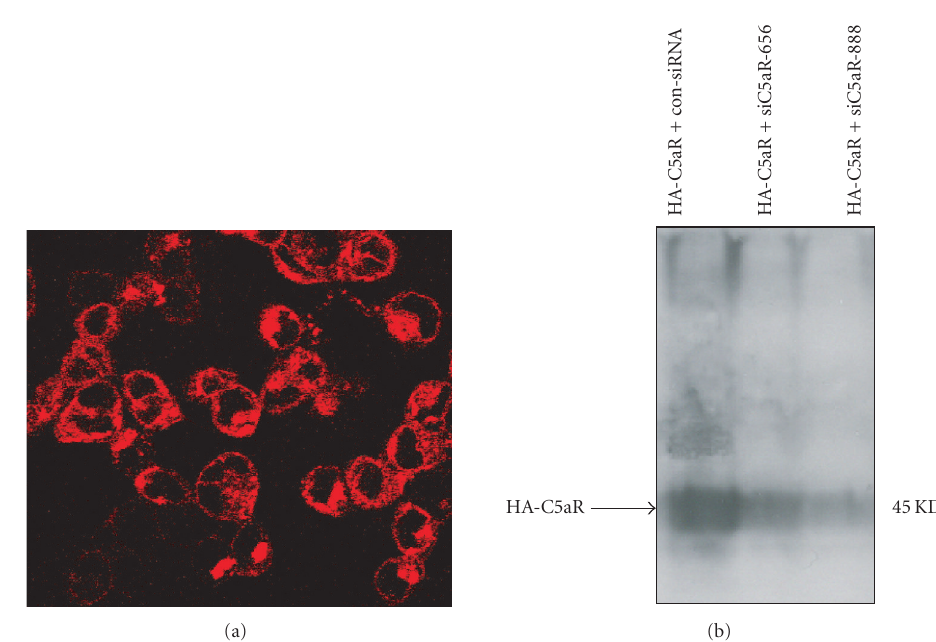
Figure 2: Oligo siRNA inhibition of C5aR protein expression in HEK293 cells. HEK293 cells were cotransfected with HA-tagged C5aR plasmid, control siRNA, or C5aR siRNA oligos. (a) Forty-eight hours after transfection, transfected cells were fixed in paraformaldehyde and stained with the anti-mouse C5aR primary antibody and goat anti-rabbit Alexa 568 secondary antibody. Expression and localization of C5aR were visualized by confocal microscope under lissamine-rhodamine channel (Zeiss). (b) Cell lysates from transfected cells were subjected to Western-blot analysis using anti-mouse C5aR antibody